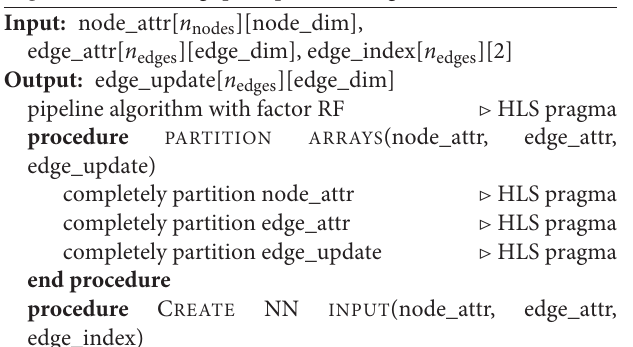
Algorithm 1 : Throughput-optimized edge